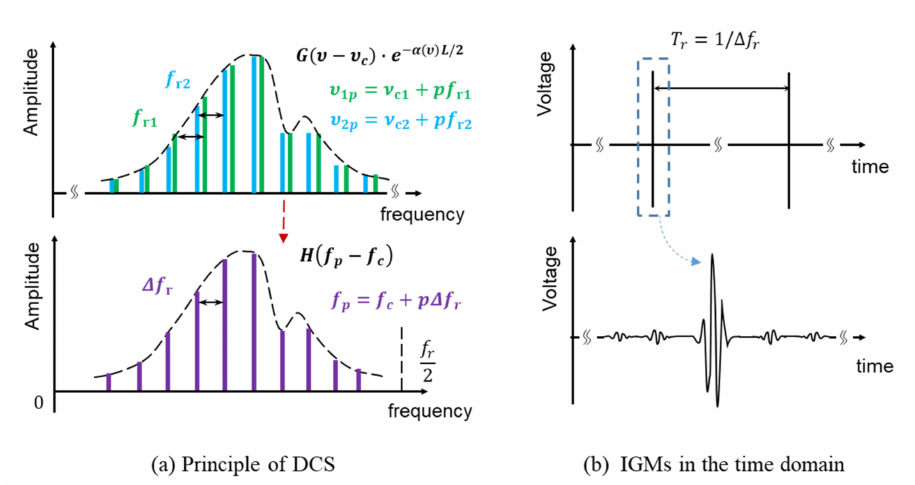
Figure 3. Schematic of DCS principle and interferograms (IGMs) signal. ( a ) Dual-comb down-conversion process. Optical frequency modes of two OFCs (blue and green) beat reciprocally to generate radio frequency (RF) frequency components (purple) according to a mode-to-mode heterodyne interference. ( b ) Typical time-domain IGMs. The carrier-envelope pulse sequence is the inverse Fourier transform of discrete RF magnitude spectrum, while each frame is the inverse Fourier transform of continuous spectrum curve